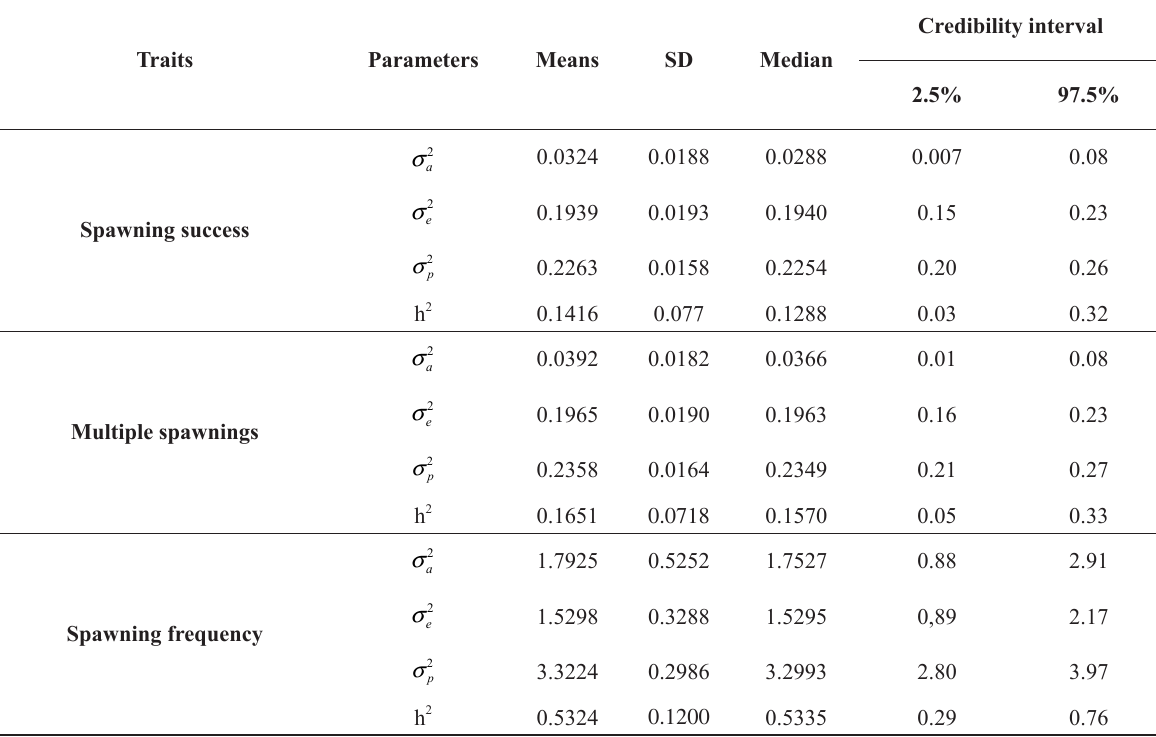
Posterior statistics for variance components and heritability for spawning success, multiple spawning, and spawning frequency in Nile